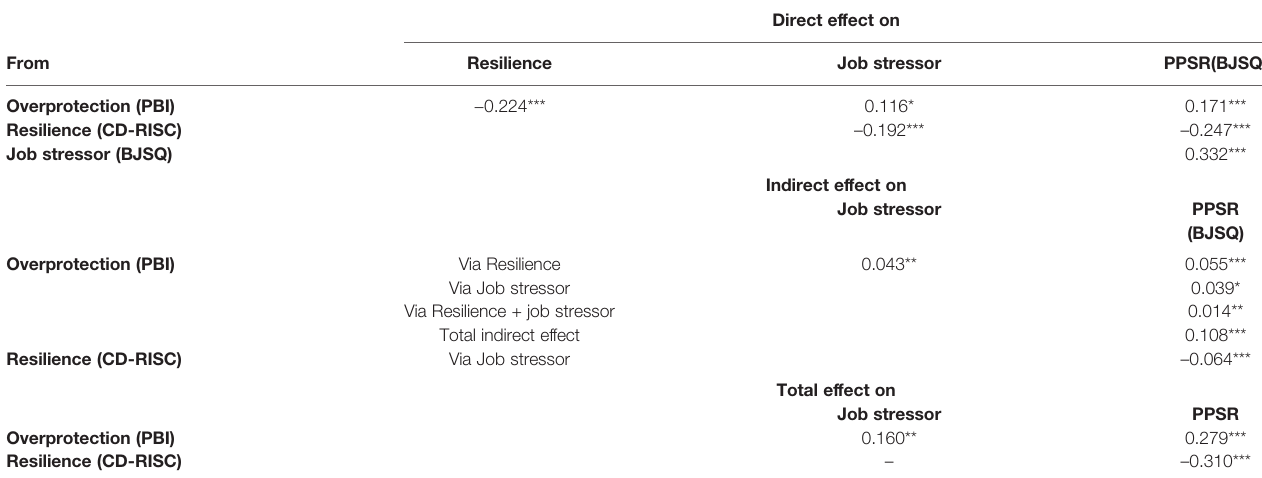
TABLE 2 | Standardized path coef fi cients between each variable of parental